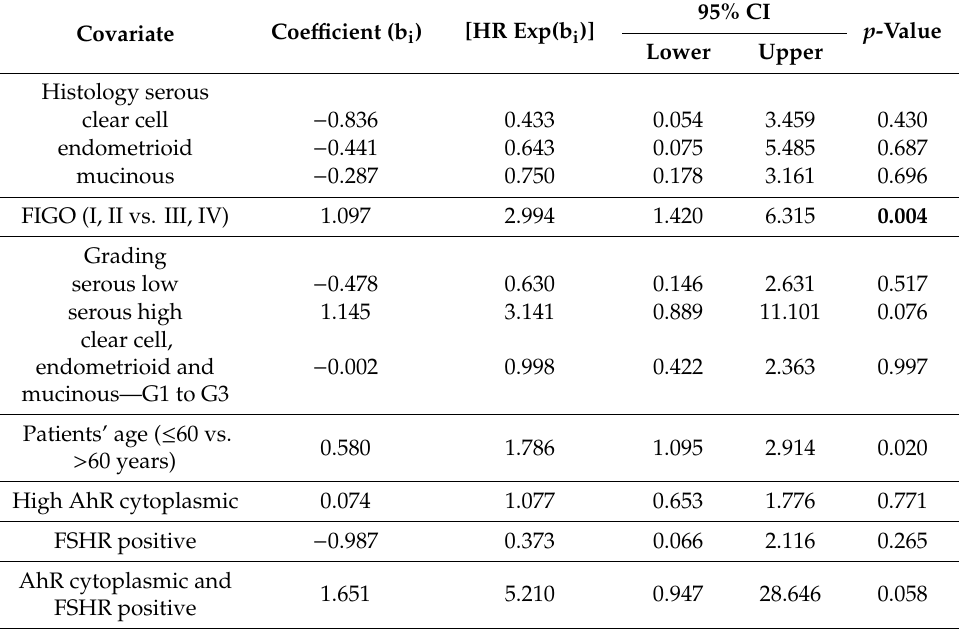
Table 3. Multivariate